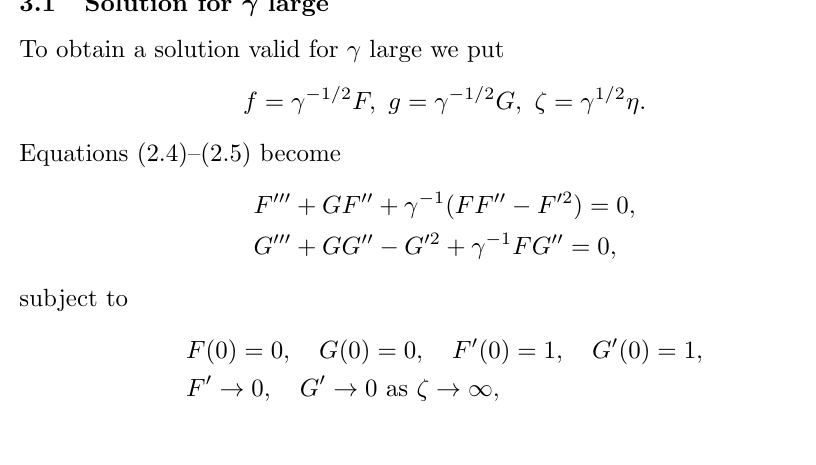
whereas there is a much greater range over which g (cid:48) changes, growing larger as γ is further reduced. The values of η where g (cid:48) achieved its outer value are much greater than those used to plot this figure, a value of η ∞ = 50 . 0 being used in the numerical